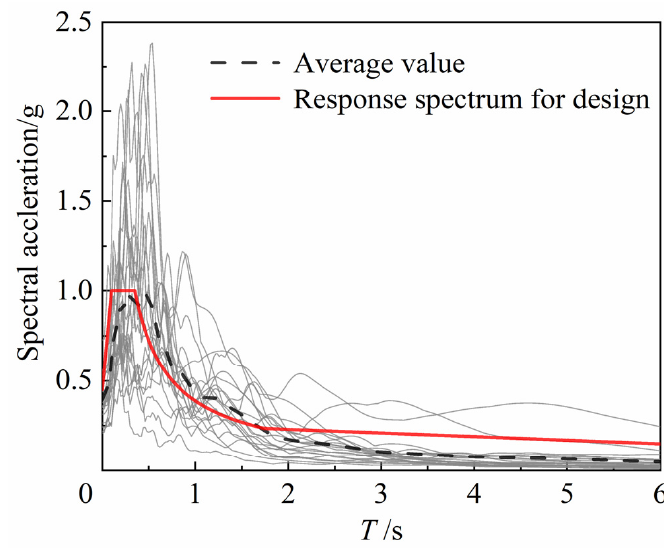
Figure 10. Response spectrums.